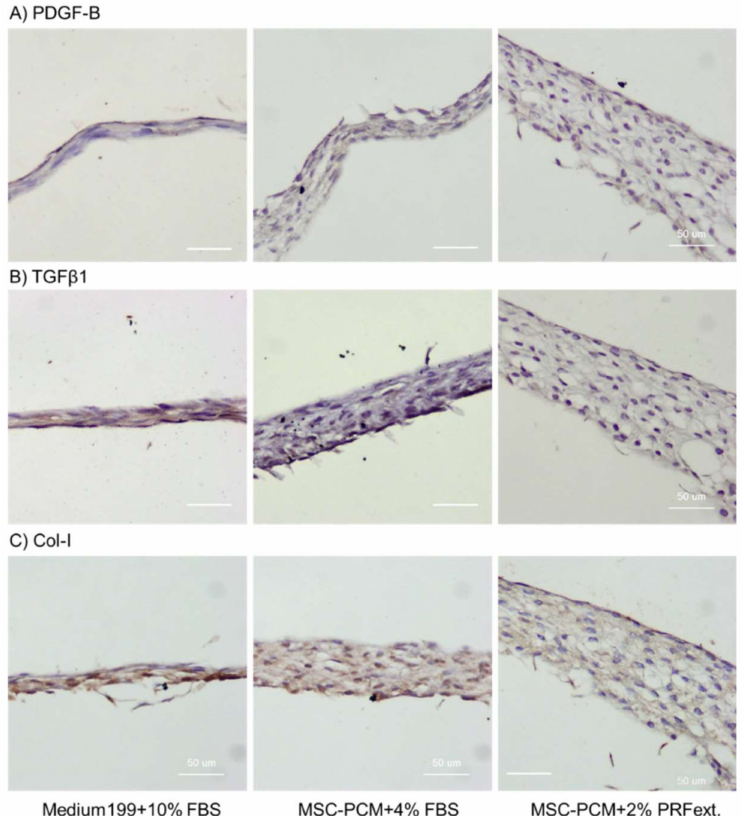
Figure 6. Effects of different culture media on the expression of platelet-derived growth factor-B (PDGF-B), transforming growth factor beta 1 (TGF β 1), and collagen type I in the central region of periosteal sheets (outgrowth area). Immunohistochemical staining with visualization using 3 (cid:48) -diaminobenzidine (DAB) (positive: dark brown). These data are representative of five independent experiments. Bar = 50 µ m.